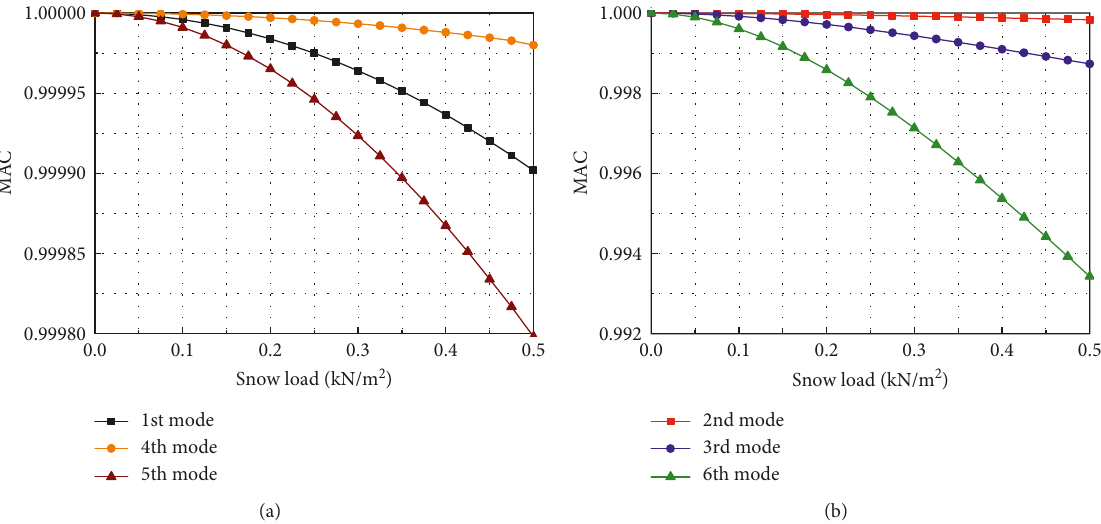
Figure 23: MAC values of the mode shapes on transverse direction under uniformly distributed snow load: (a) the 1st, 4th, and 5th modes and (b) the 2nd, 3rd, and 6th modes.